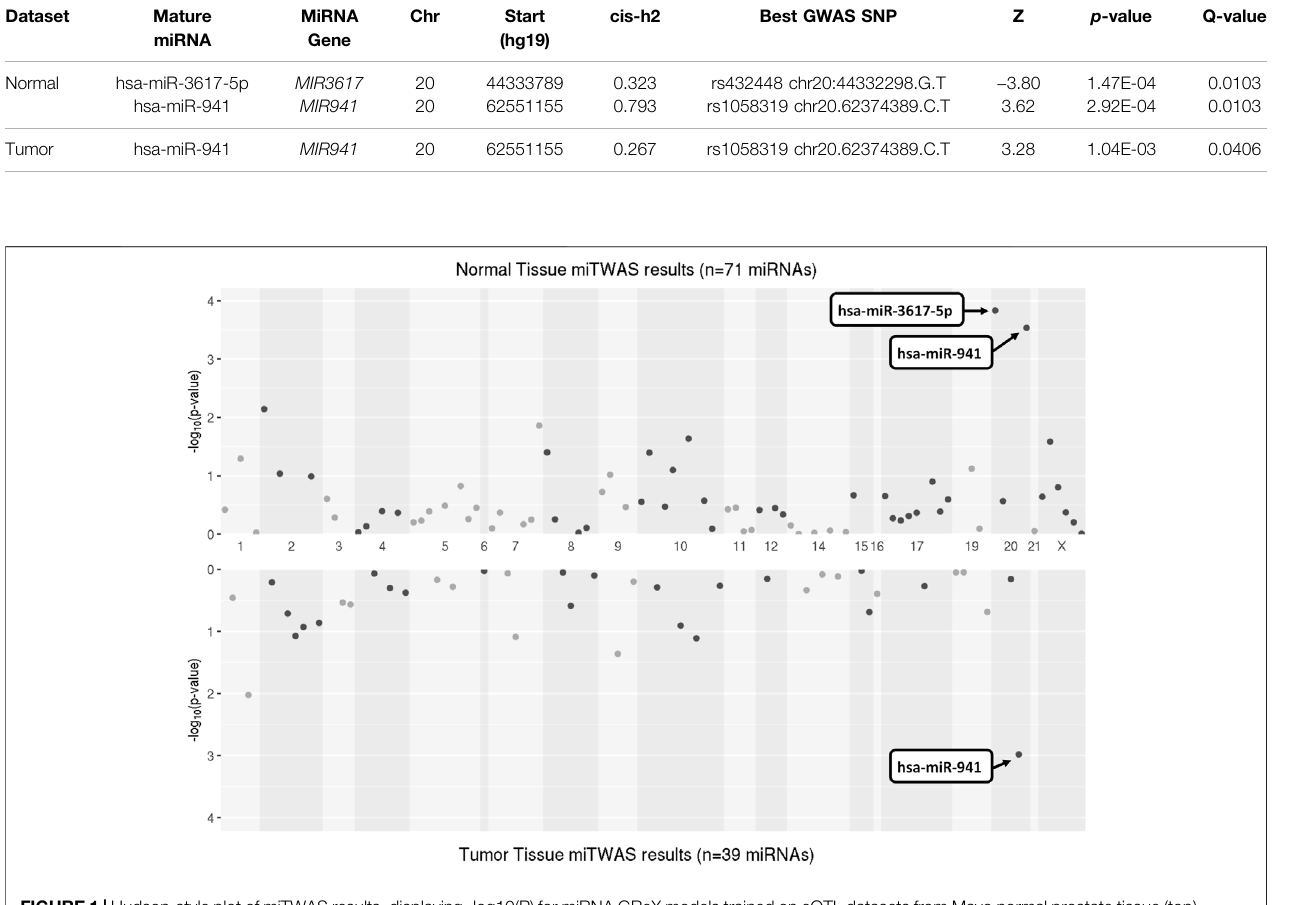
Frontiers in Genetics |